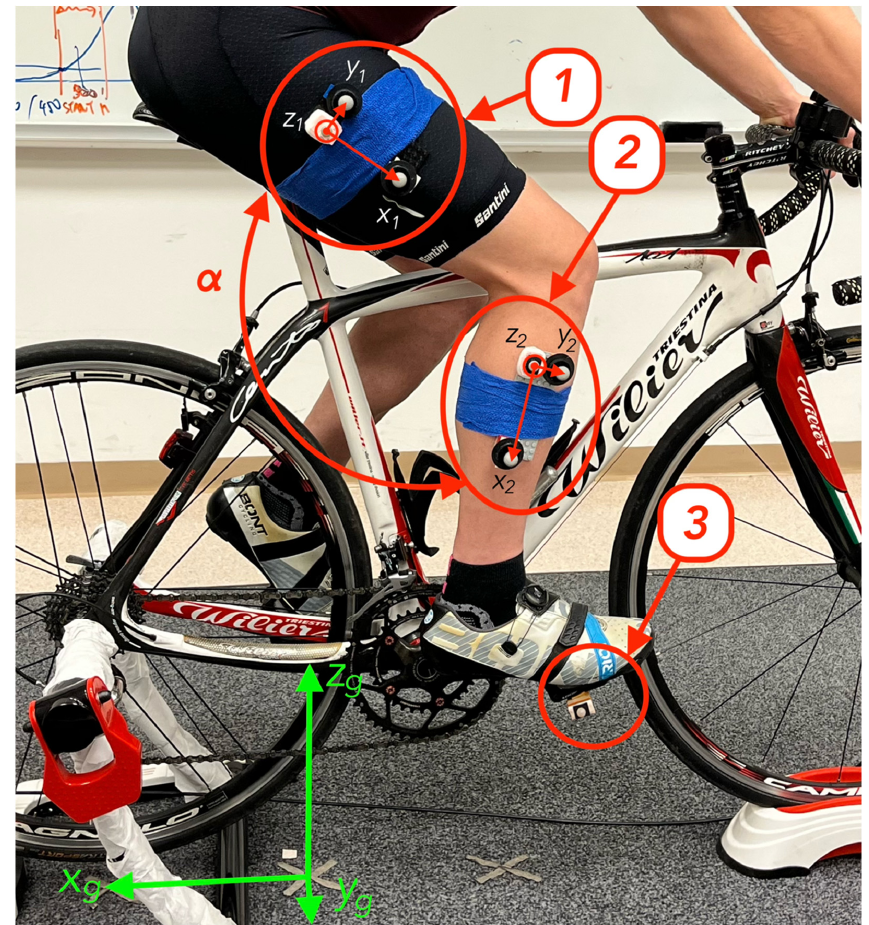
Figure 2. Experimental setup for measuring the knee joint angle. 1 and 2 denote the rigid bodies used for determining the knee joint angle with the optical motion tracking system, whereas 3 denotes the additional marker used for the crank angle measurements. The two IMU devices are positioned below the central points of the two rigid bodies.